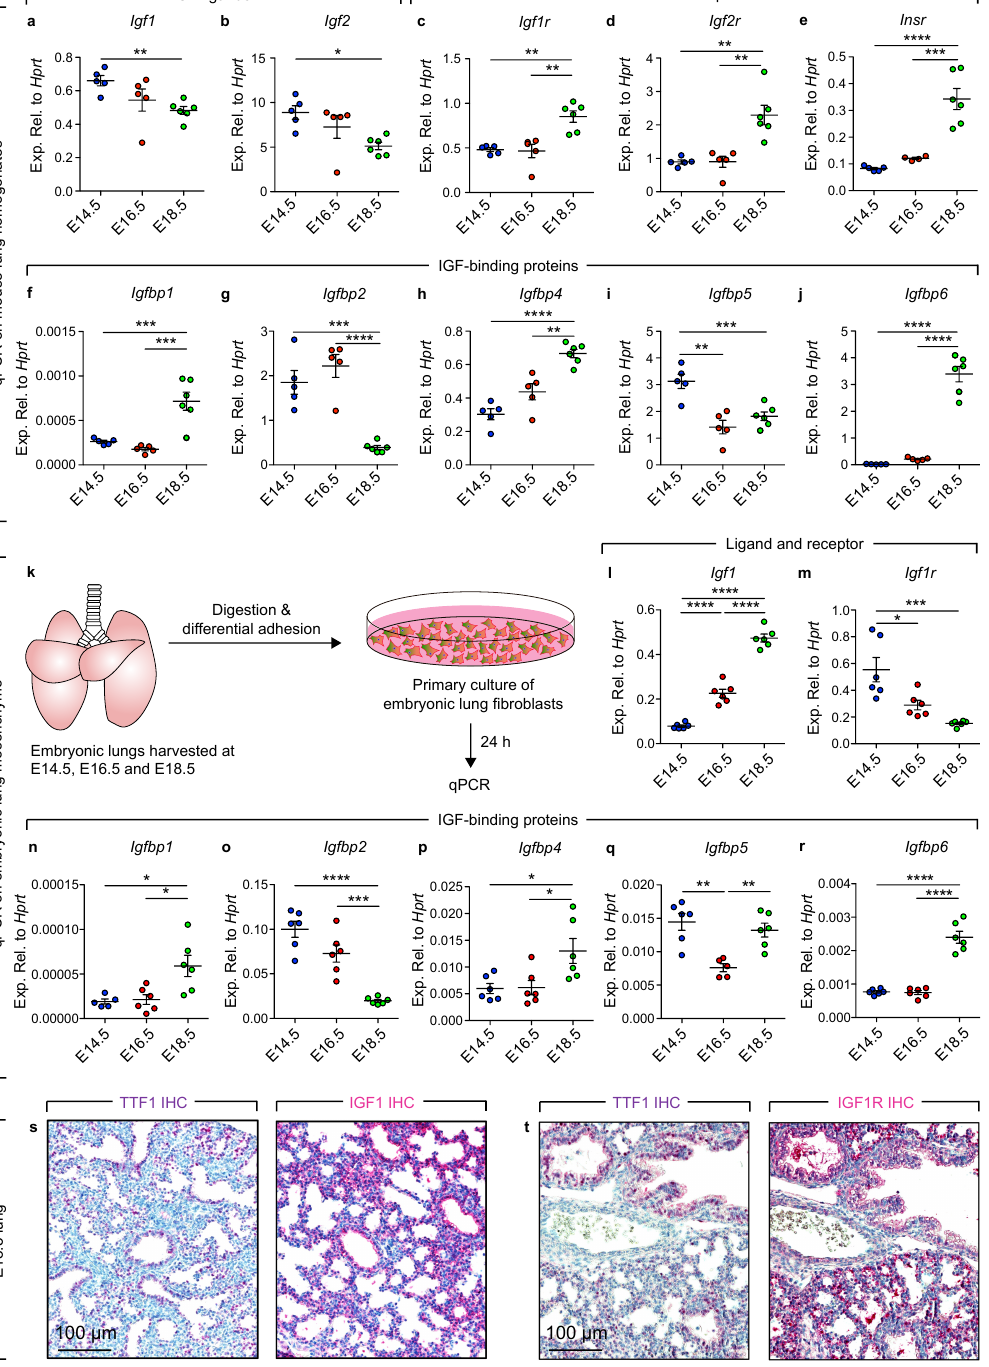
Figure 1. Expression profile of IGF signaling components during lung development. ( a – j ) qPCR on lung homogenates at the indicated developmental stages; ( k ) Scheme for experimental design; ( l – r ) qPCR on primary mesenchymal cells at the indicated developmental stages. ( s ) Immunohisto- chemistry for TTF1 and IGF1 on E18.5 mouse lungs. ( t ) Immunohistochemistry for TTF1 and IGF1R on E18.5 mouse lungs. One-way ANOVA was used to compare the means. ( a – j ) E14.5: n = 5, E16.5: n = 5, E18.5: n = 6; ( l – r ) E14.5: n = 5–6, E16.5: n = 5–6, E18.5: n = 6. * p < 0.05, ** p < 0.01, *** p < 0.001, **** p <